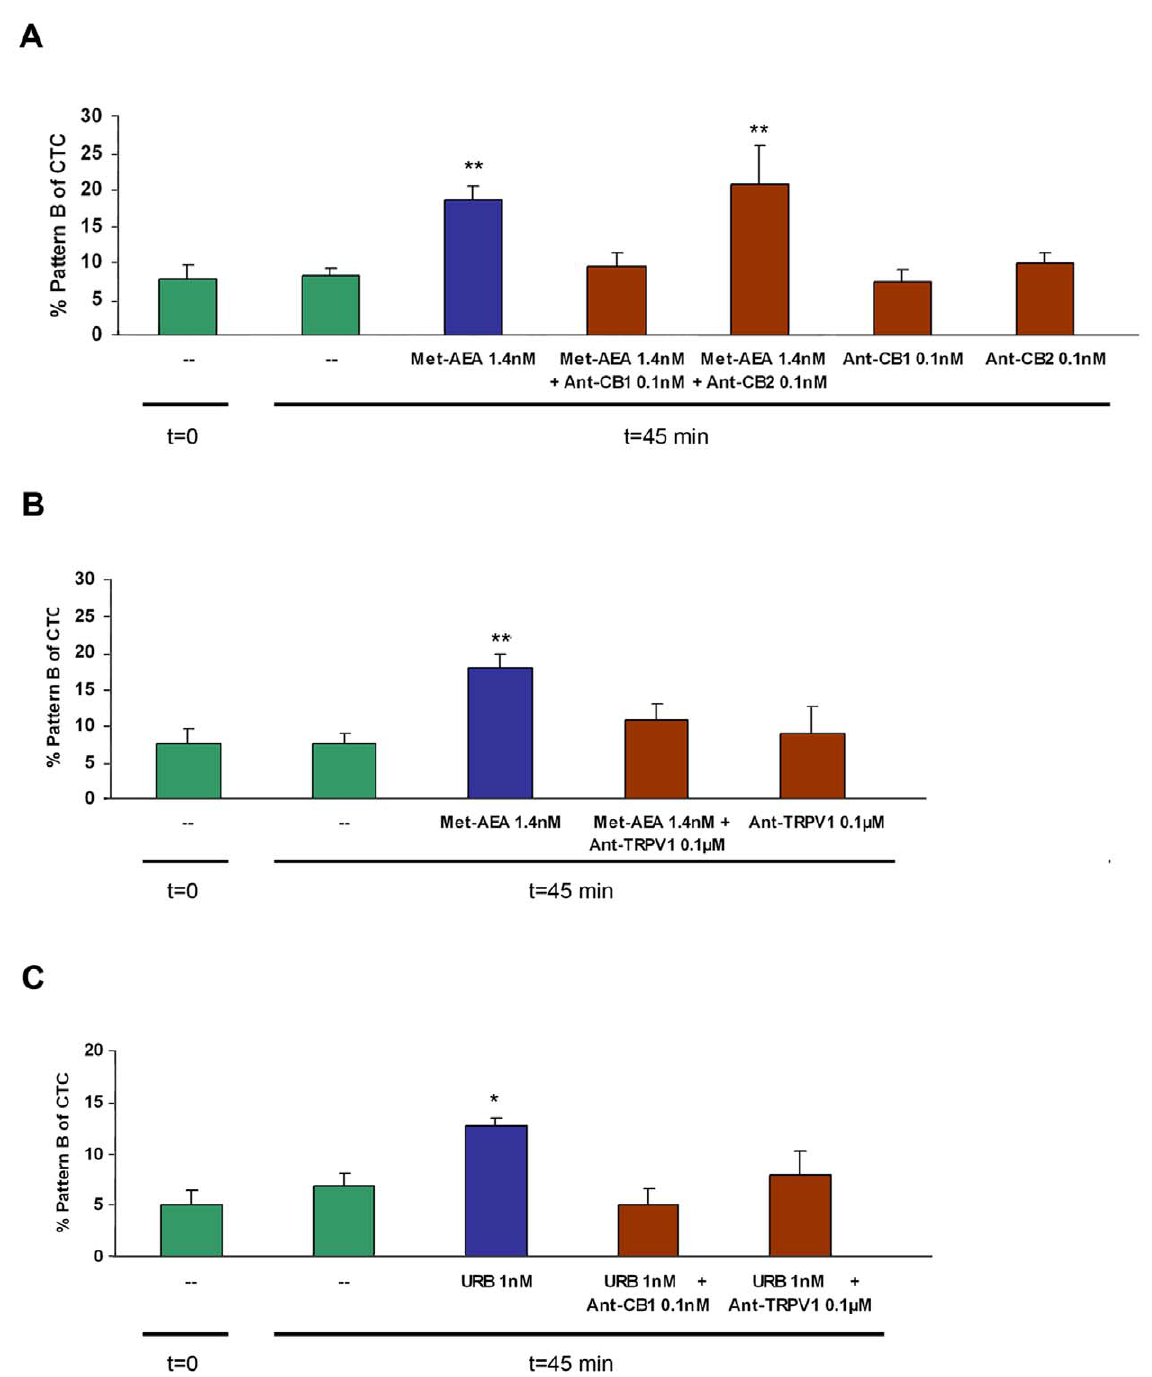
Figure 4. Evaluation of CB1, CB2 and TRPV1 participation in bull sperm capacitation. Spermatozoa were incubated for 45 min at 38.5 u C with different treatments. Bars indicate the percentage of capacitated spermatozoa (pattern B) determined by CTC. Data are expressed as mean 6 SEM. A : sp-TALP (control), Met-AEA (1.4 nM), Met-AEA plus Ant-CB1 (CB1 antagonist SR141716A; 0.1 nM), Met-AEA plus Ant-CB2 (CB2 antagonist SR144528); **p , 0.01 Met-AEA vs. control and Met-AEA plus Ant-CB1 (n=6). **p , 0.01 Met-AEA plus Ant-CB2 vs. control and Ant-CB2 (n=4). B : sp- TALP (control), Met-AEA (1.4 nM) or Met-AEA plus Ant-TRPV1 (TRPV1 antagonist capsazepine; 0.1 m M); **p , 0.01 Met-AEA vs. control and Met-AEA plus Ant-TRPV1 (n=6). C : sp-TALP (control), URB597 (FAAH inhibitor; 1 nM), URB597 plus Ant-CB1 or URB597 plus Ant-TRPV1; *p , 0.05 URB597 vs. control, URB597 plus Ant-CB1 and URB597 plus Ant-TRPV1 (n=5). (—) t=0 and t=45, sp-TALP at 0 and 45 min (control) incubation respectively.